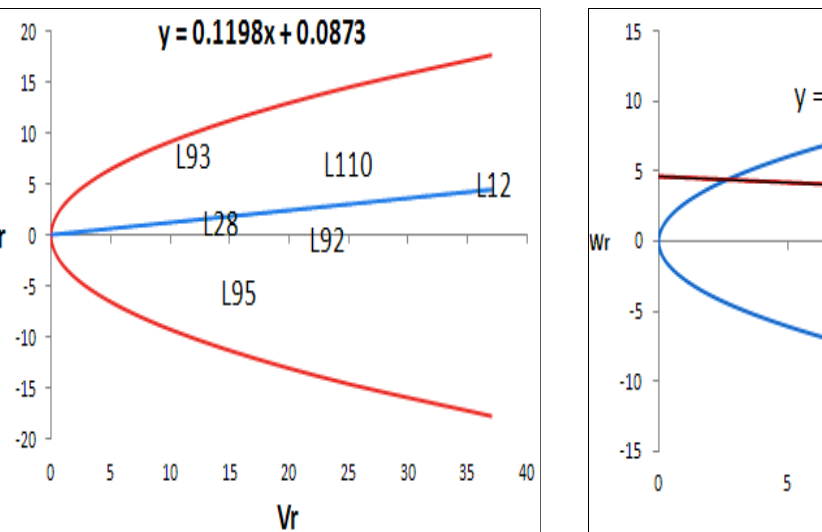
Fig. 1a: Wr/Vr graphs for days to 50% flowering under NI Fig. 1b: Wr/Vr graphs for days to 50% flowering under